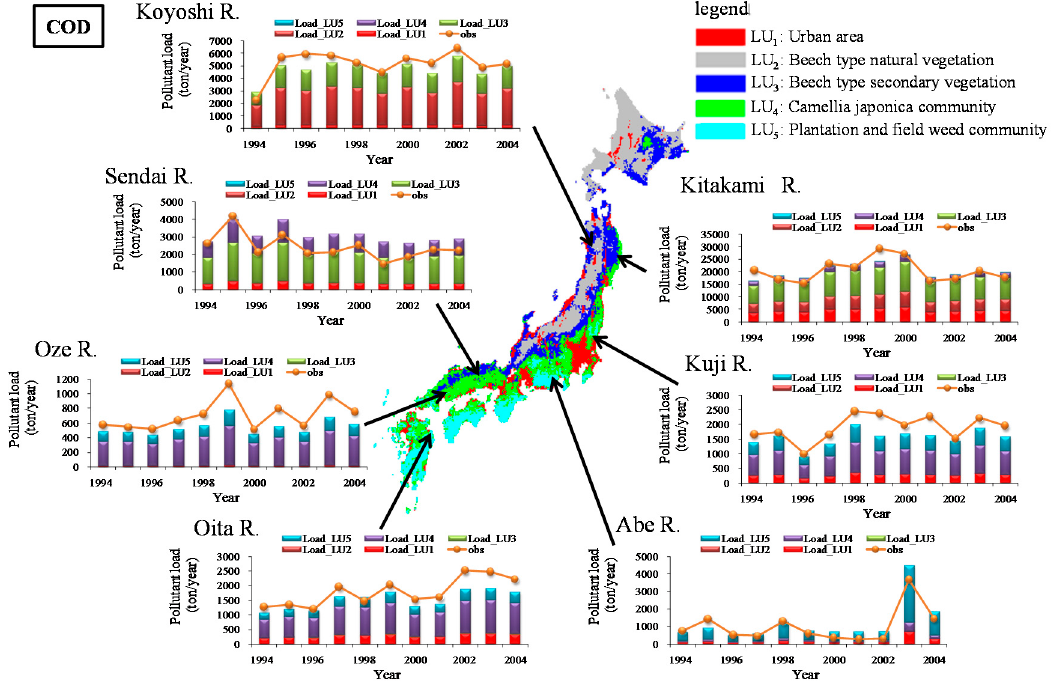
Figure 7. Chemical oxygen demand (COD) loads associated with different land covers in 30 Japanese catchments from 1994 to 2004.